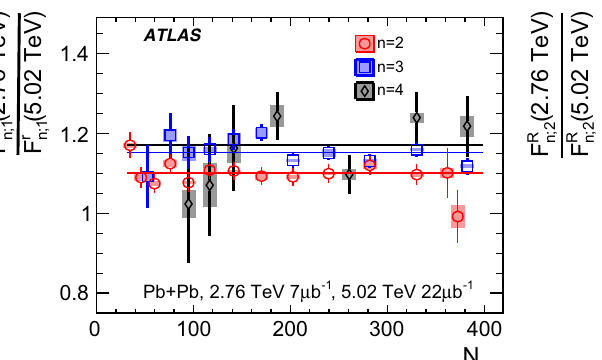
Fig. 13 Centrality dependence of ratio of F r F R values (right panel) at 2.76 and 5.02 TeV. The lines indicate the n ; 2 average values in the range 30 < N part < 400, with the results andfit